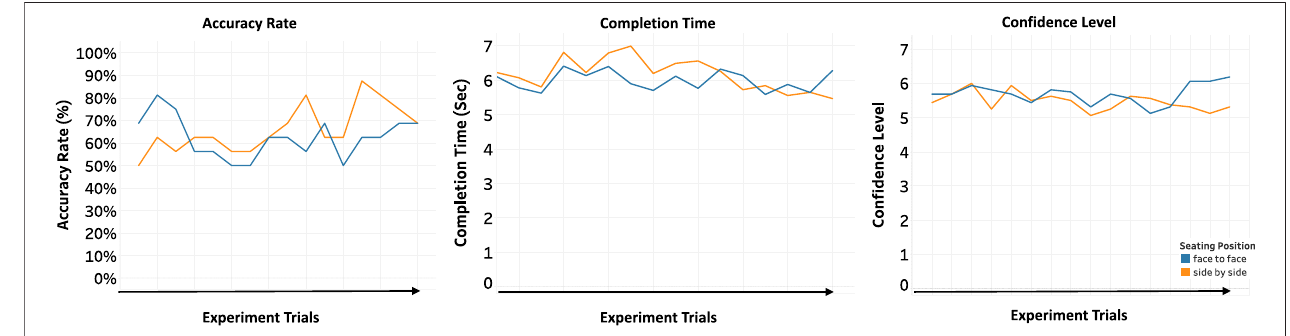
FIGURE10| Averageaccuracyrate,average completiontime, and averagecon fi dence acrosstrials in theAR condition (face-to-face, side-by-side).There was no apparent trend of improvement over repeated trials.